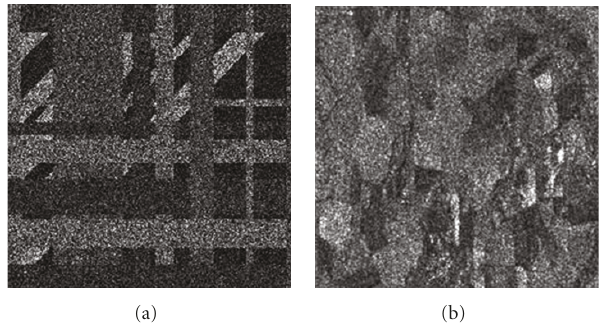
Figure 3: The degraded “SynImag” image with L = 2 (a) and the degraded SAR image with L = 10